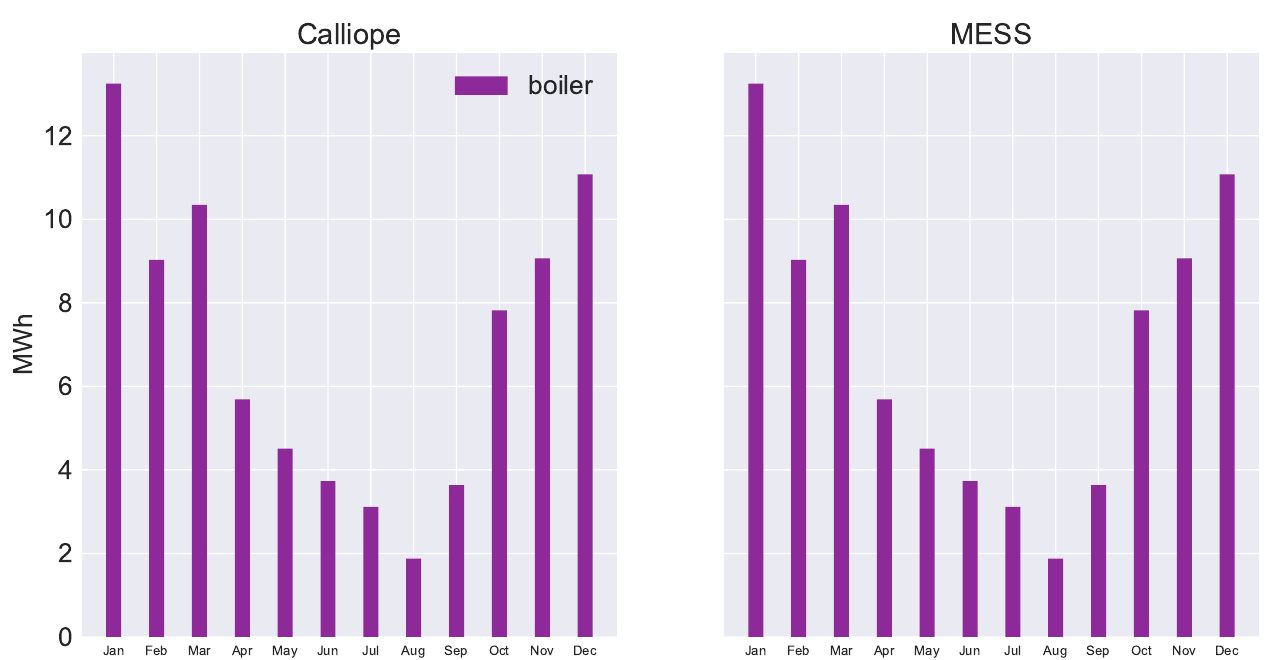
Figure A3. Monthly heating per technology source: Location X2—Calliope and MESS comparison.